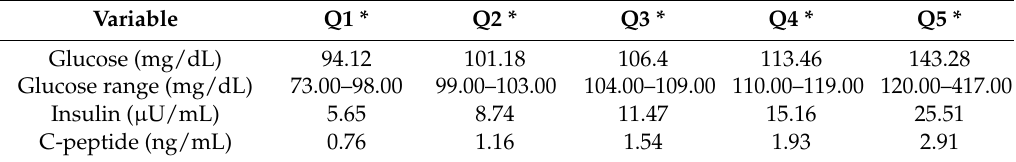
Table 2. Mean value of glucose, insulin and C-peptide at each quintile of